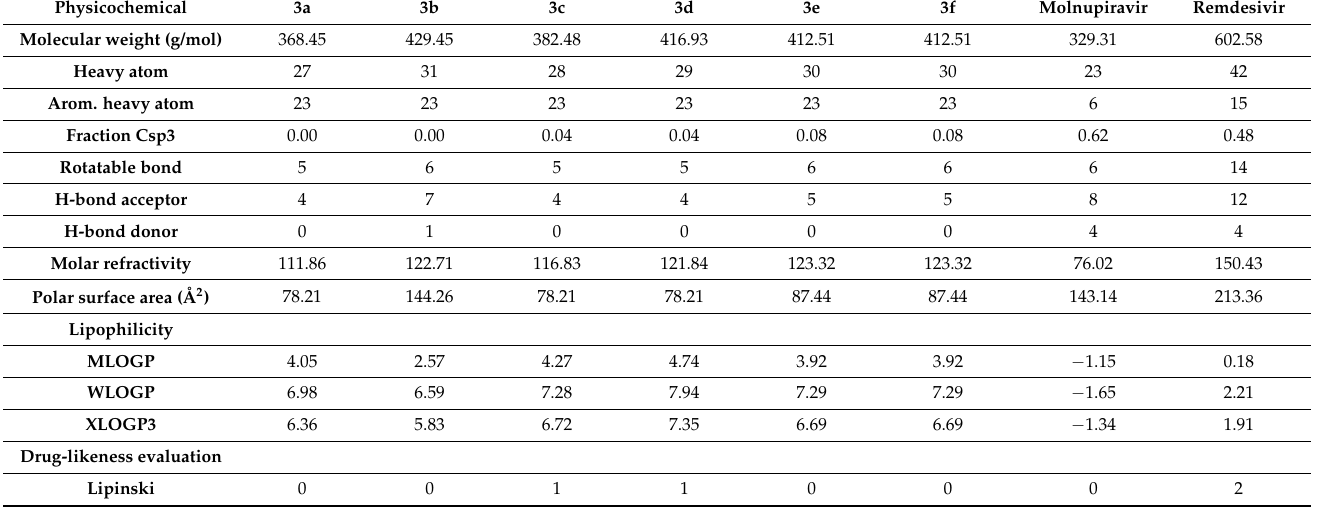
Table 5. Physicochemical properties and lipophilicity of ligands 3a–f in comparison with the ap- proved drugs Molnupiravir and